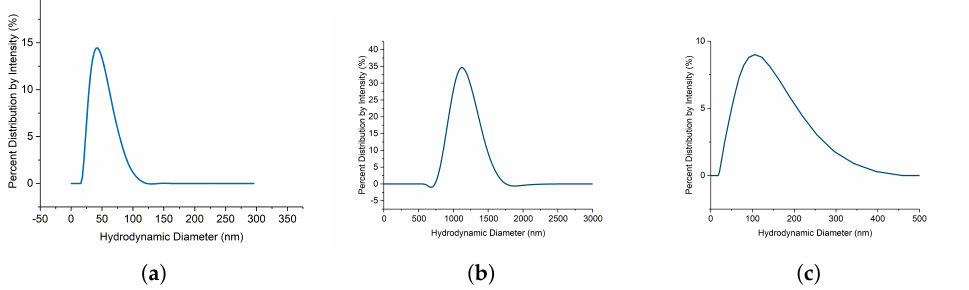
Figure A4. Hydrodynamic diameter (per averages of intensity) of ( a ) unfunctionalised (hydroxyl), ( b ) aminopropyl, and ( c ) octyl functionalised Ludox AS40 in MilliQ water suspension after